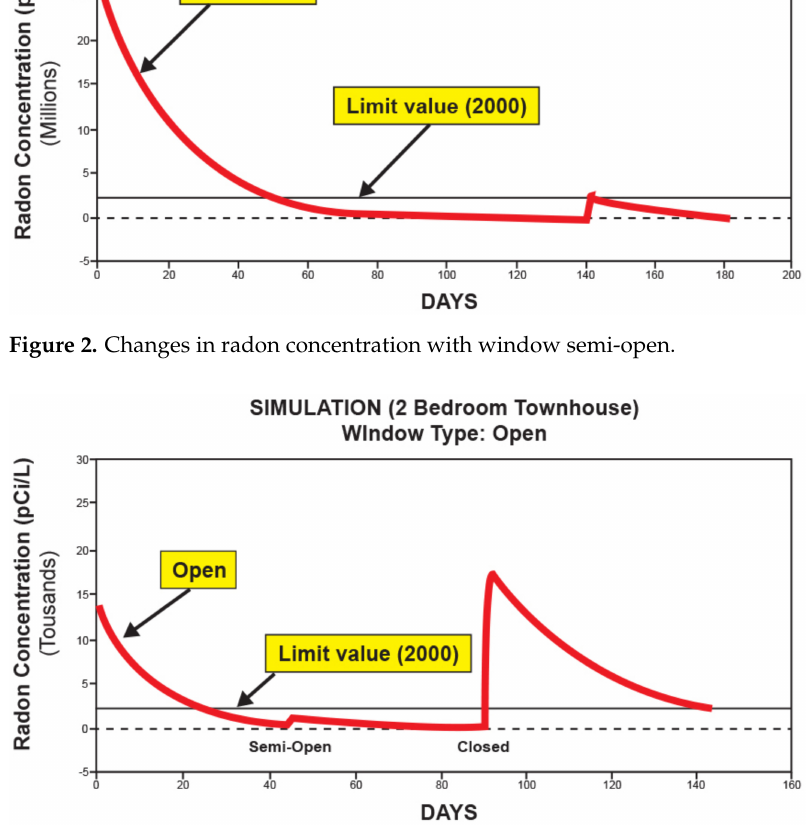
Figure 3. Changes in radon concentration with window fully open. Table 7. Simulation-2